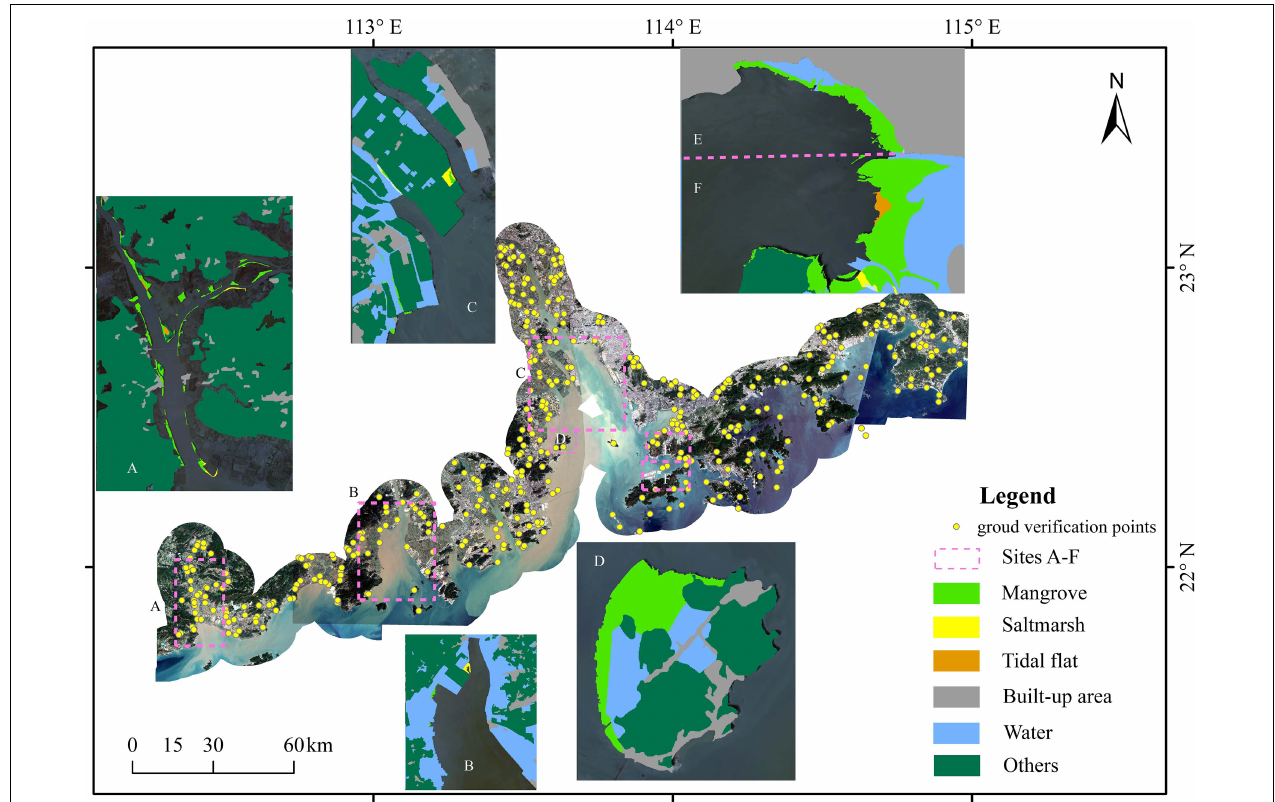
FIGURE 2 | Satellite images covering the study area in 2018, clipped with a 10 km buffer of shoreline. The subplots are the classification results by the Random Forest algorithm of sites